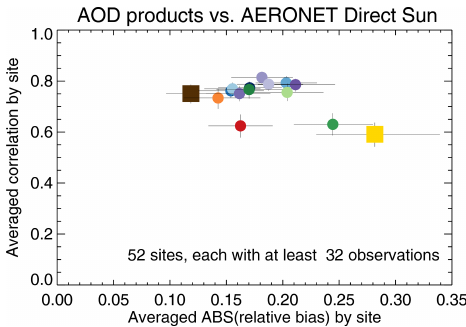
Figure 8. Evaluation of satellite products with AERONET per site, averaged over all sites. Squares indicate products used in the present study, and circles indicate products used in Schutgens et al. (2020). Error bars indicate a 5%–95% uncertainty range based on a boot- strap analysis (see Sect. 3.2) of sample size 1000 (the bootstrap was performed on the contributing AERONET sites). Colours indicate the satellite product (see also Fig. 1). Products were individually collocated with AERONET DirectSun L2.0 within 3h. All products use the same sites, each of which produced at least 32 collocations. POLDER-SRON and FL-MOC were excluded from this analysis due to lack of